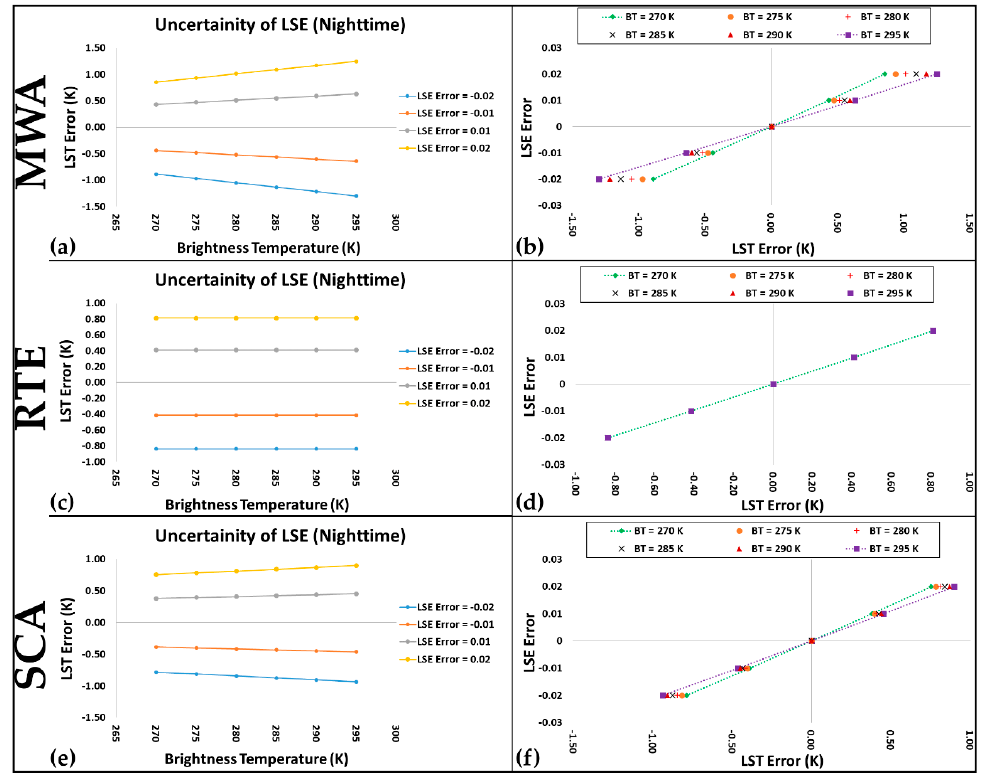
Figure 4. Sensitivity results of MWA ( a , b ), RTE ( c , d ), and SCA ( e , f ) to LSE for nighttime Landsat 8 images. LST error computed as in Equation (16).